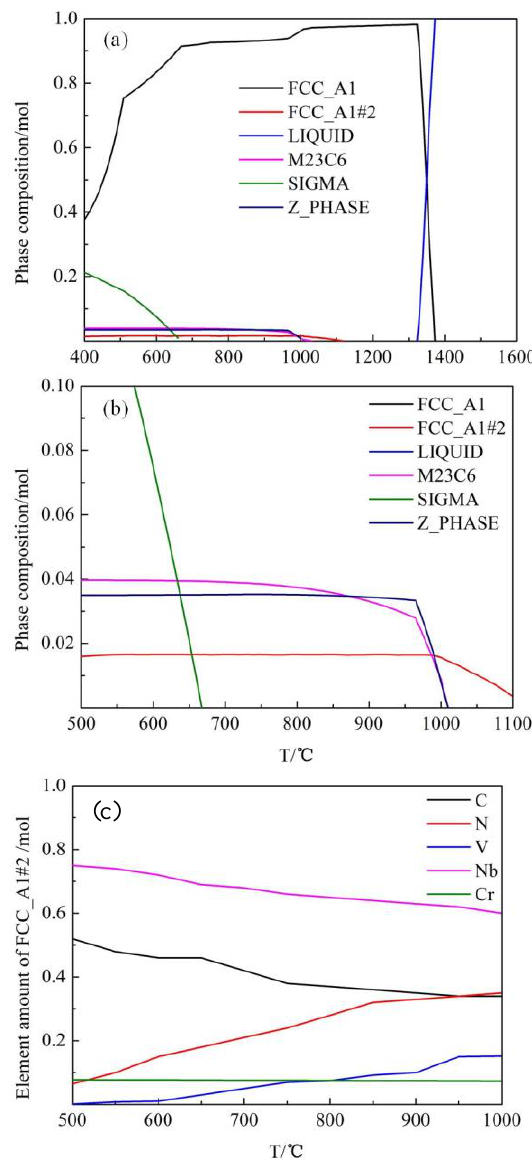
Figure 1. Equilibrium phase fractions of precipitates for experimental steel calculated by Thermal-Calc. ( a ) 0~1 mol of Y axis, ( b ) 0~0.1 mol of Y axis, ( c ) variation of C, N, V, Nb and Cr in FCC_A1#2.